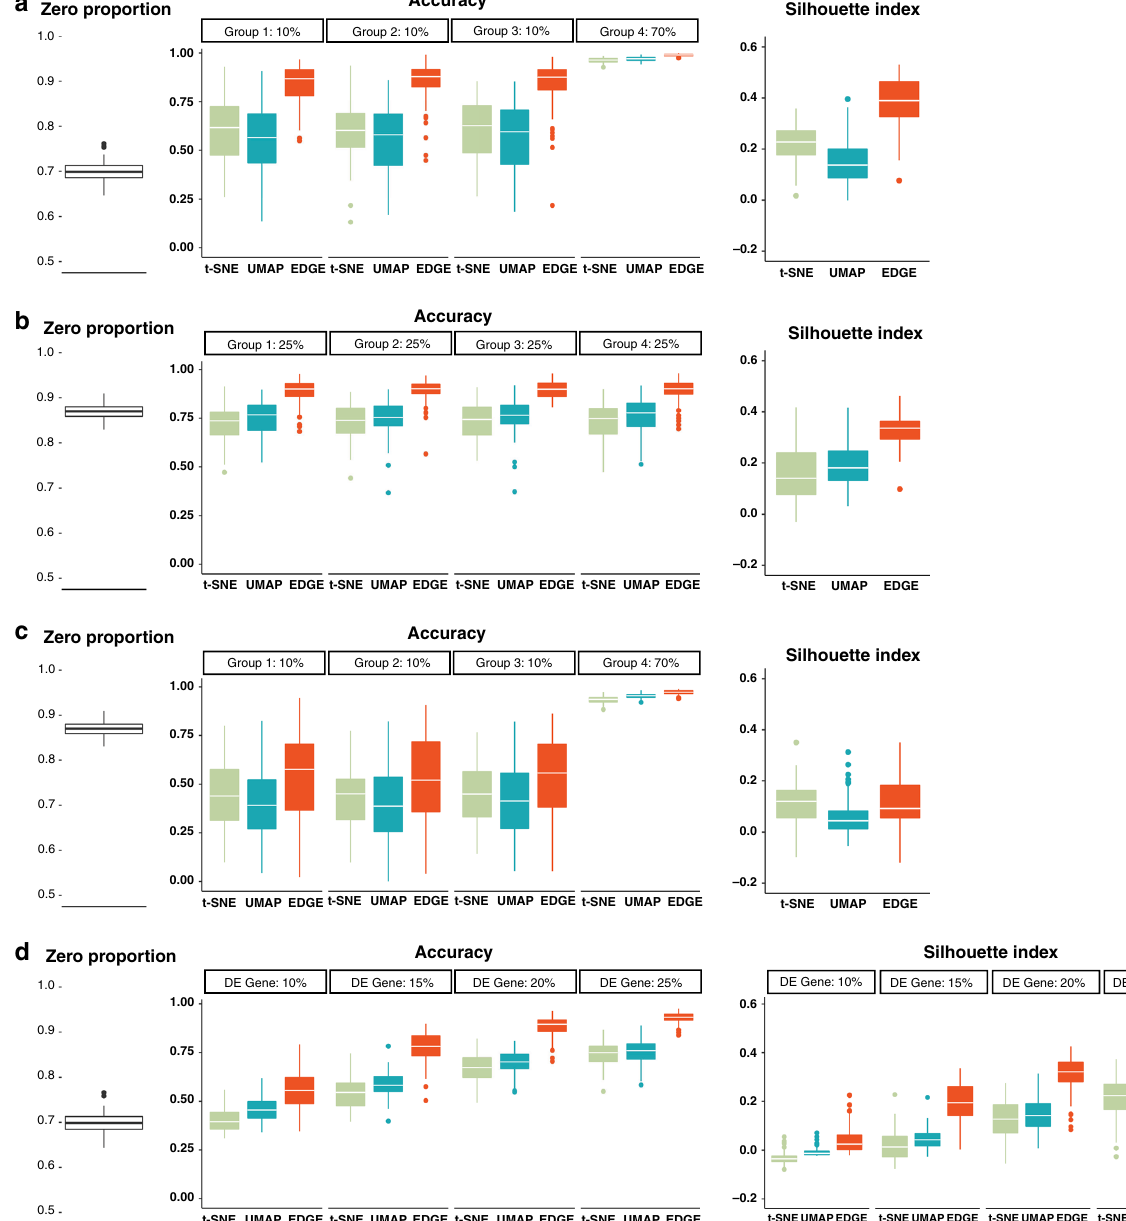
Fig. 2 EDGE preserves the structure of cell populations. The results over 100 replications of simulation studies are shown in a (Scenario 1), b (Scenario 2), c (Scenario 3), and d (Scenario 4). In each panel, the left fi gure presents observed zero proportions of the simulated scRNA-seq datasets; the middle fi gure shows the accuracy of random forests in predicting cell cluster labels using the learnt embeddings as input; the right fi gure displays the calculated silhouette indices of embeddings. In the boxplots, we show the median (central lines), fi rst and third quartile (box limits), and the whiskers extended to the lowest and highest points within 1.5 interquartile range of the fi rst and third quartiles, respectively.